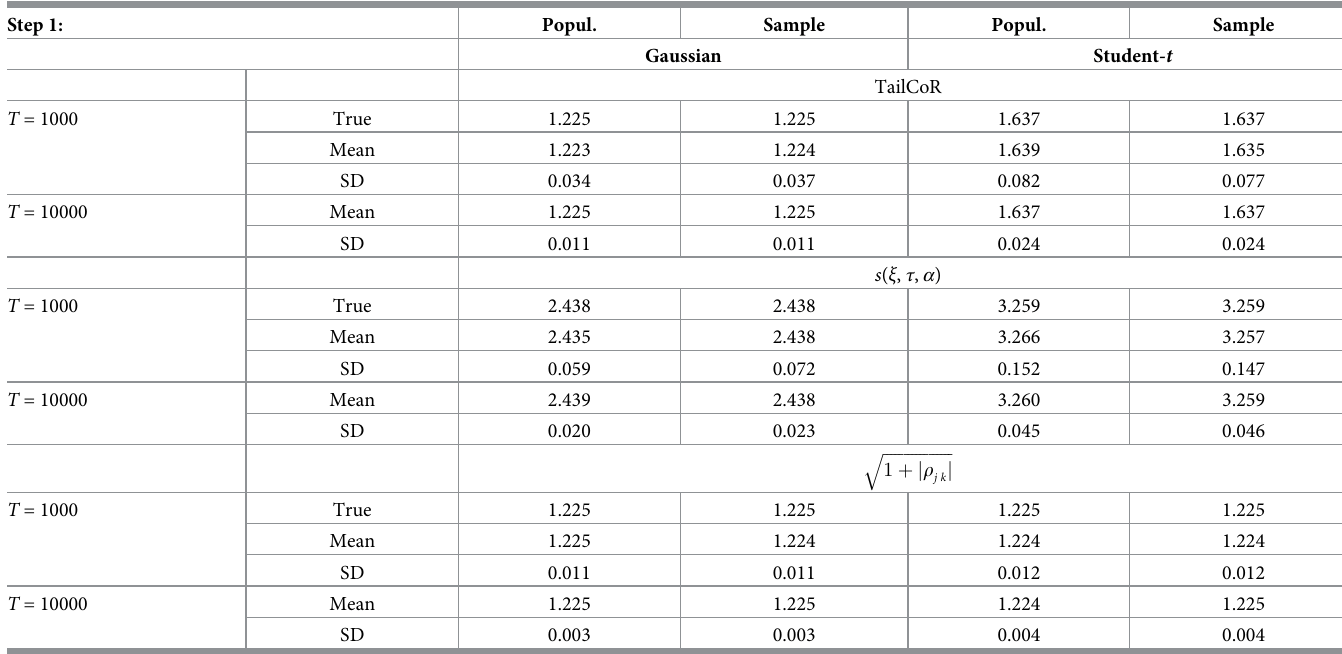
Means and standard deviations of estimates of TailCoR and its components when using population (Popul. in top row) or sample marginal quantiles in step 1. All results are for H = 1000 and ξ =